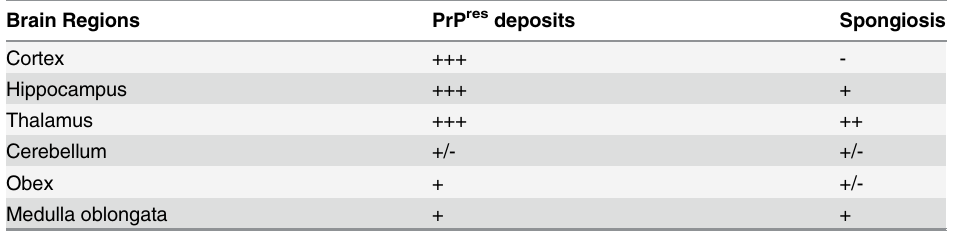
Table 1. Regional distribution of PrP res and vacuolation in the brain of transgenic rabbits expressing ovine PrP challenged with LA21K fast prions. Brain Regions PrP res deposits